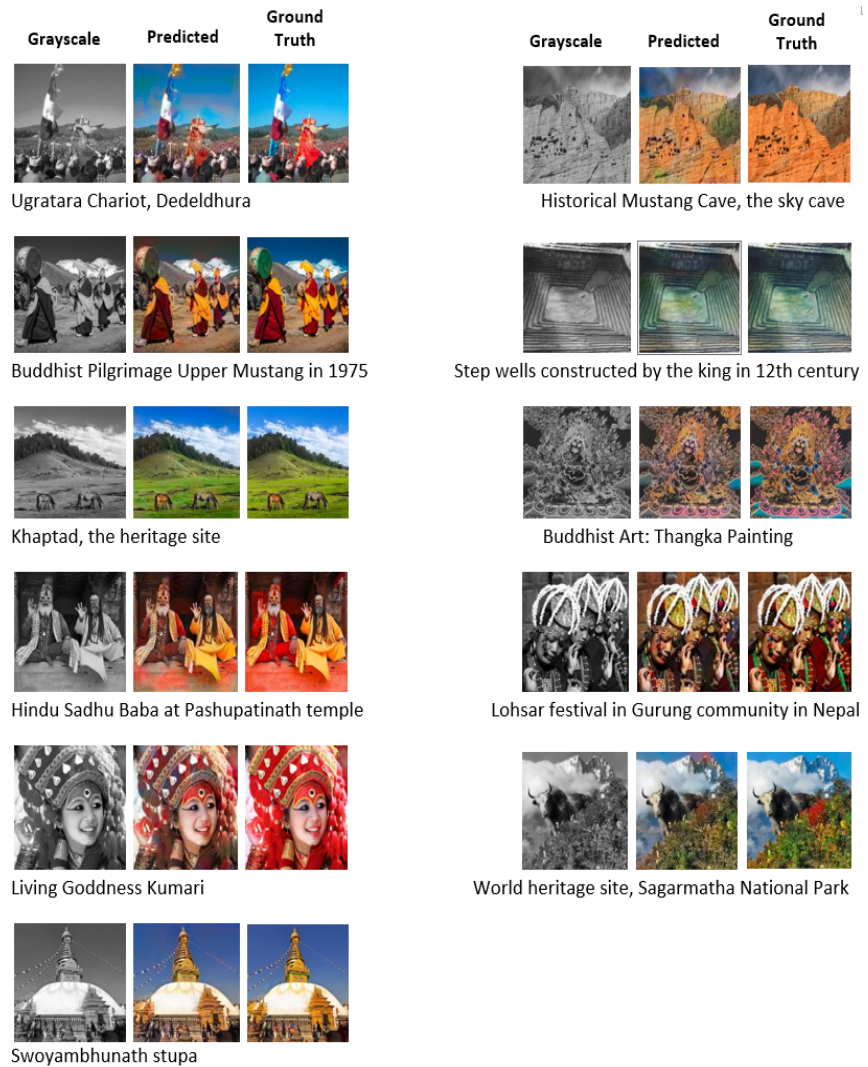
Figure 6. Results obtained from the model on some of the images from the validation set. The 1st and 4th columns represent input grayscale image, the 2nd and 5th columns are colorized outputs and the 3rd and 6th columns represent the original images.